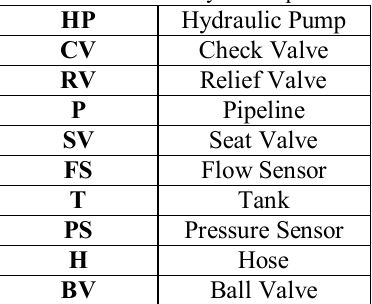
Table 1. List of used hydraulic parts